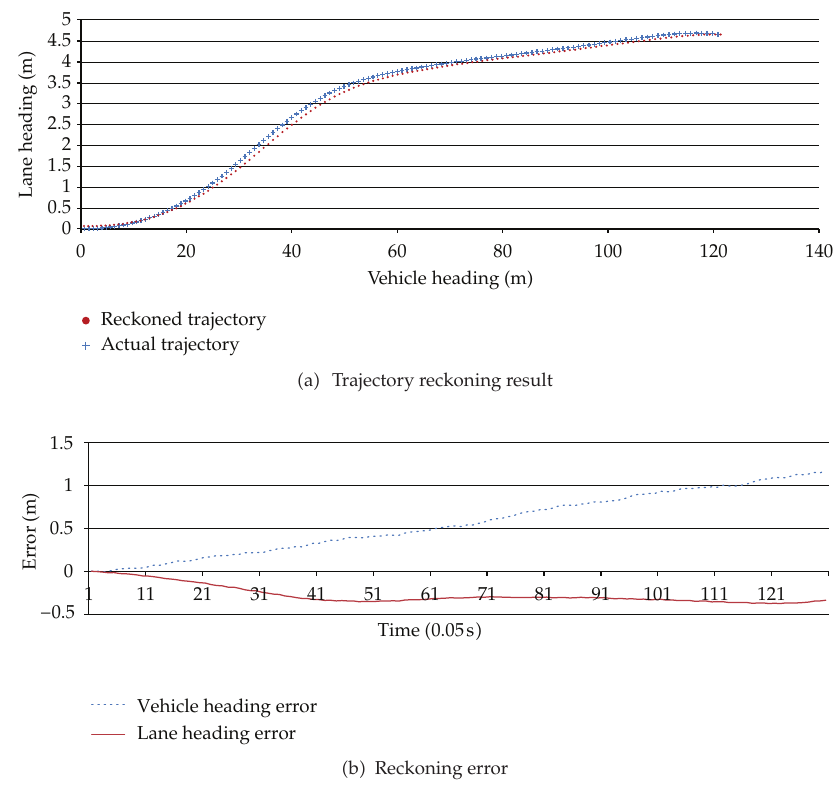
Figure 13: Example of trajectory reckoning result of lane